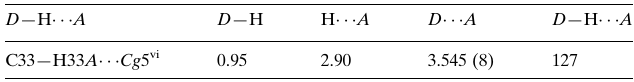
Table 2 (cid:3) -Ring hydrogen-bond geometry (A˚ , (cid:4) ) for (I).